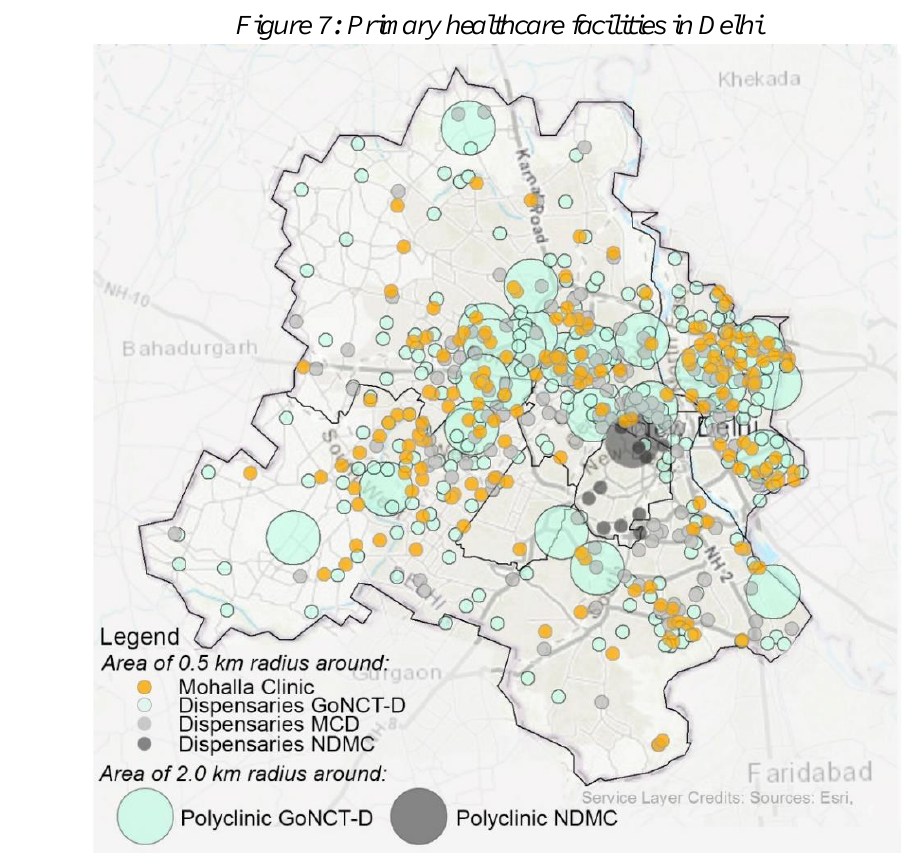
Figure 7: Primary healthcare facilities in